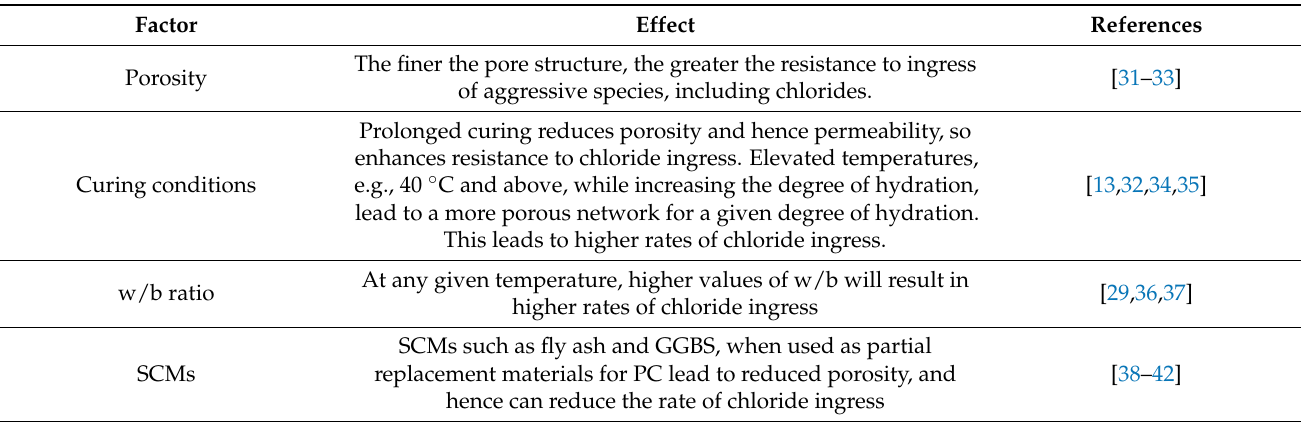
Table 2. Factors influencing the rate of chloride ingress into